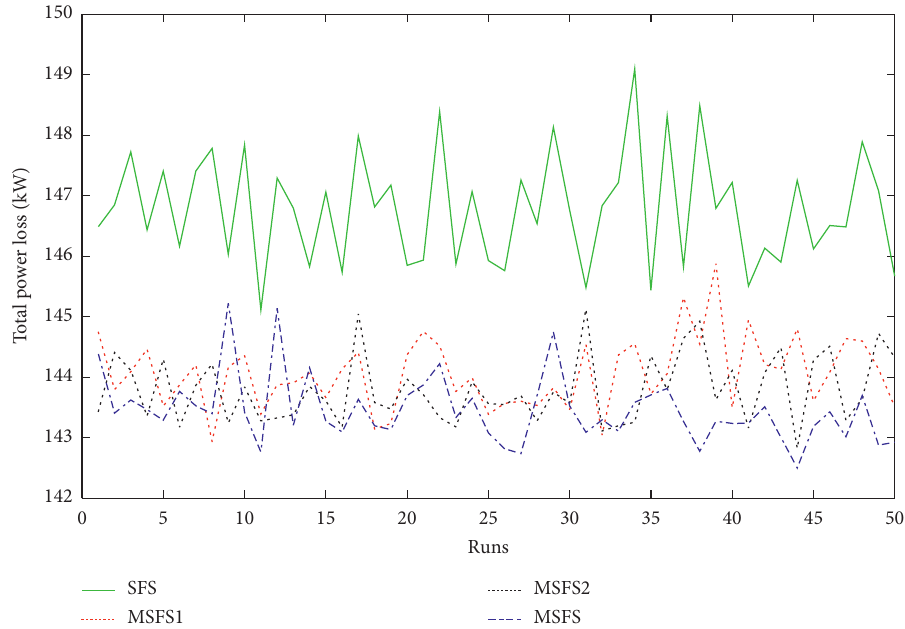
Figure 30: Total power loss of 50 trial runs obtained by SFS methods for case 4 of the 85-bus